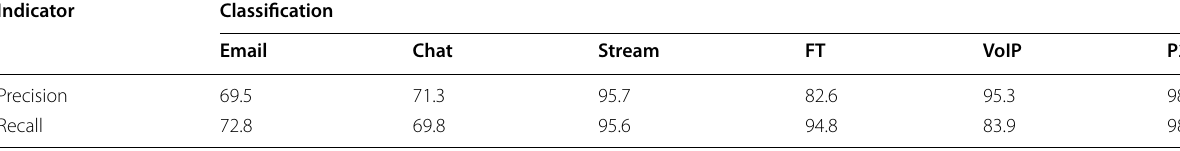
Table 3 Accurate experimental precision and recall for the non-encrypted category of Experiment 3 Indicator